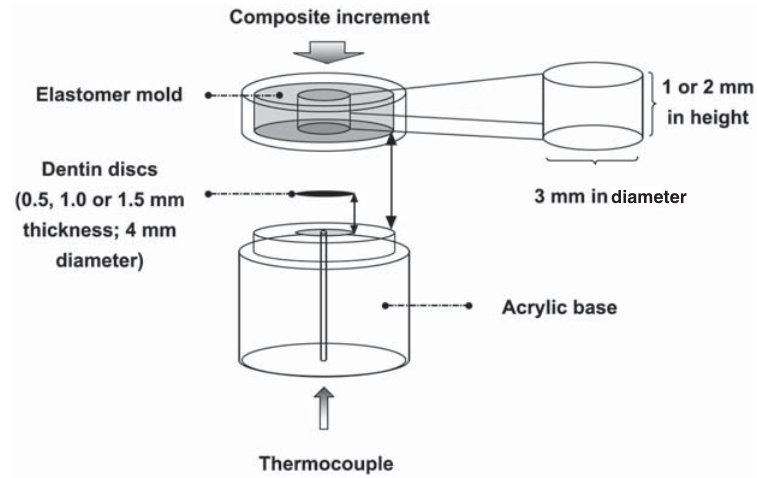
FIGURE 3- Apparatus used for measurement of temperature increase